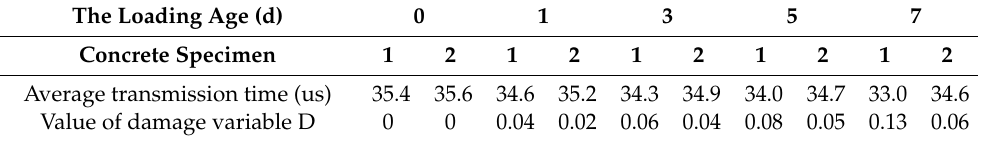
Table 2. Damage variable D of concrete